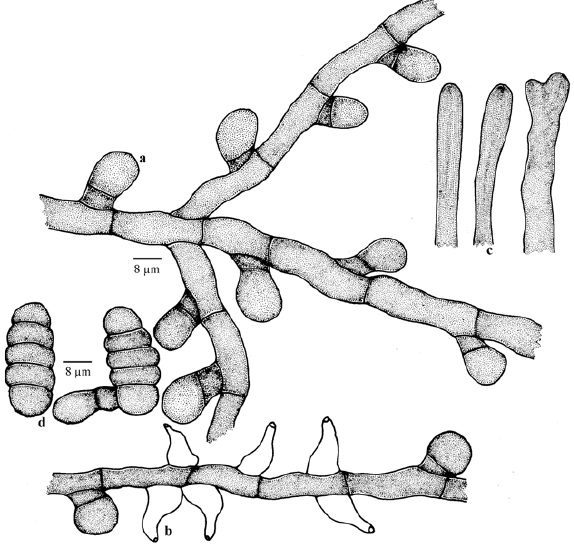
Figure 34. Meliola abri a - Appressorium; b - Phialide; c - Apical portion of mycelial setae; d -